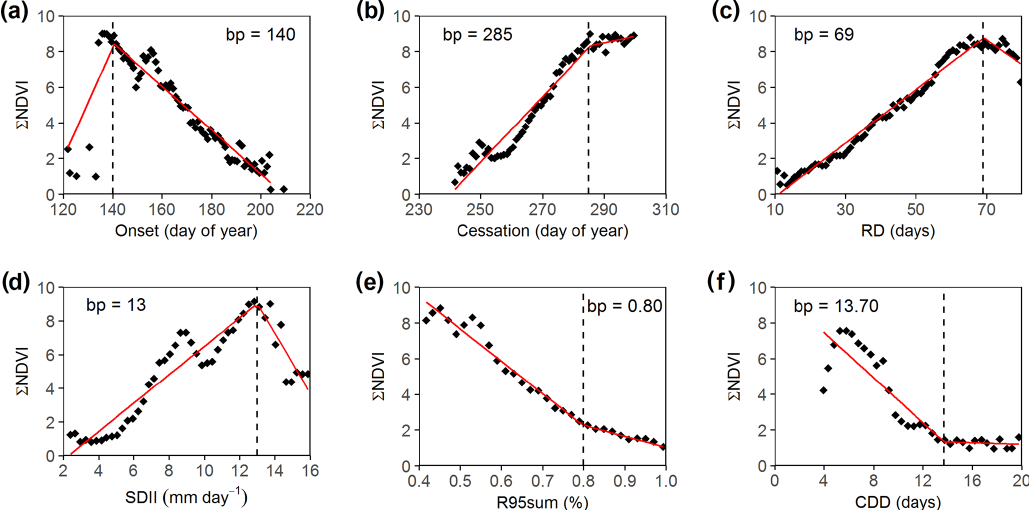
Figure 9. Growing season ANPP (individual points represent 95th percentile of P NDVI value for each seasonal-rainfall metric bin) plotted against rainfall metrics. Solid red lines denote piecewise regression between growing season ANPP and seasonal-rainfall metrics, and dashed lines indicate the breakpoint (bp) for rainfall individual